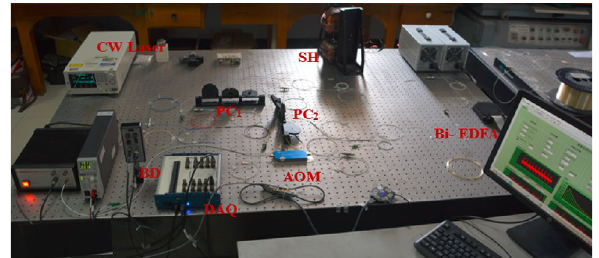
Figure 2. The experimental setup of the space-domain active FCRD magnetic field sensing system.